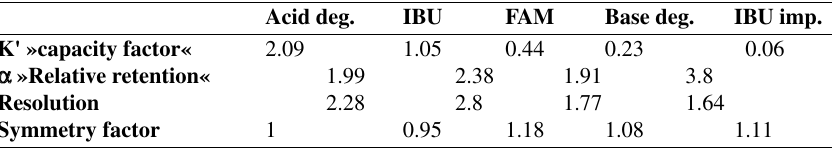
Table 4: Parameters required for system suitability testing of TLC-densitometric method